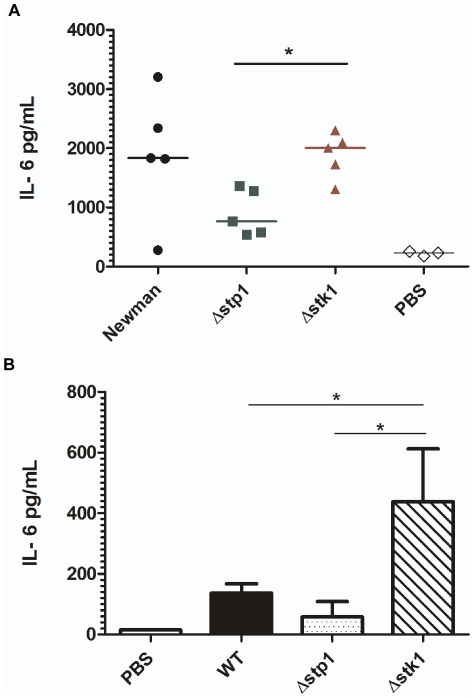
Stp1 and Stk1 regulate the host immune response to S. aureus Newman.(A) Cytokine IL-6 levels were measured in kidney homogenates obtained from infected mice at 5 days post-inoculation. IL-6 levels were significantly lower in kidneys obtained from Δstp1 mutant-infected mice compared to Δstk1 mutant-infected mice (P value = 0.003). (B) Bone marrow derived macrophages (BMMΦ) were stimulated with WT, Δstp1 or Δstk1 S. aureus cells and cytokine IL-6 levels measured as described in the Methods. Secretion of IL-6 was increased in response to S. aureus Δstk1 in comparison to Δstp1 or WT (P value = 0.04). The experiment was repeated three times and similar results obtained. Data shown represent the mean and SD of one experiment.